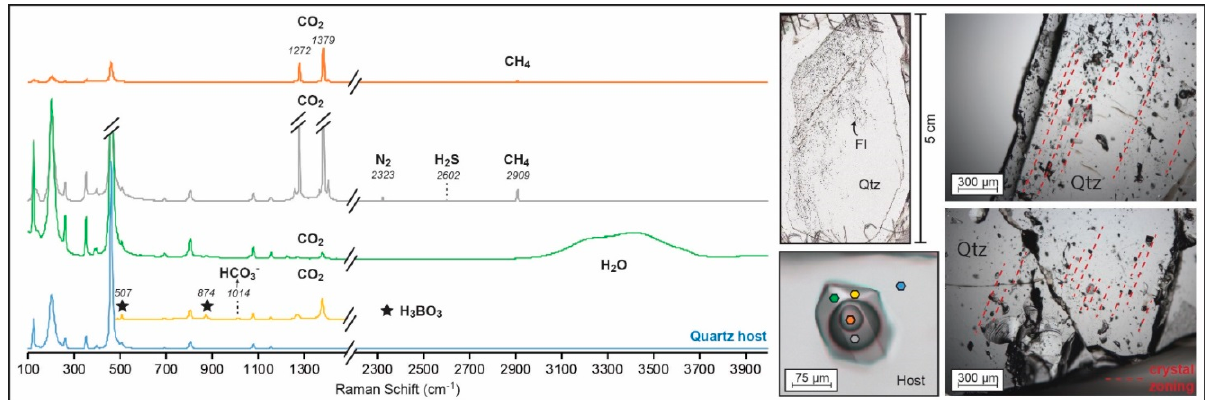
Figure 3. Representative Raman spectra of the multiple phases within the quartz-hosted Lened fluid inclusions compared to its host. For the green and yellow spectra, CO 2 is dissolved in the hydrous phase. The identification of species was performed following [48]. Orange and grey spectra correspond to gaseous and liquid CO 2 , respectively; the green spectra shows the aqueous phase; and the yellow spectra is zoomed on the sassolite crystal peaks, which are highlighted by black stars. All peaks are compared to the quartz host spectra in blue. FI: fluid inclusion; Qtz: quartz. Pictures of the fluid inclusions along the crystal growth zoning are shown as references of the primary origin of the inclusions.